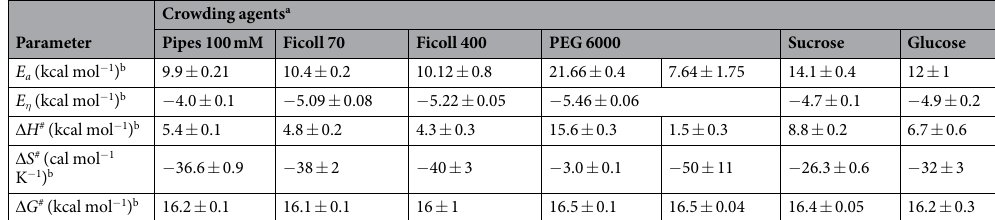
estimated in diluted buffer (Table 1). The energy of activation to viscous flow of the liquid ( E η ), the energy barrier that molecules have to overcome to move in the bulk medium, was also determined in diluted buffer (Table ST2 and Figure SF3). The values obtained were compared to the results in the presence of background agents and are described in Table 1. As the cytosol of many types of cells has been reported with macromolecular occupation typically between 20–30% of the total volume 1 , the concentration of 200 mg mL − 1 was selected for this experi- ment. As mentioned above, dextran 70 at 200 mg mL − 1 concentration yielded no reliable data and was thus not evaluated. The Arrhenius plot for Pipes 100 mM, ficoll 70, ficoll 400, sucrose and glucose showed a linear relationship between ln(k cat ) versus T − 1 values (Fig. 3). On the other hand, a more complex profile was observed for PEG